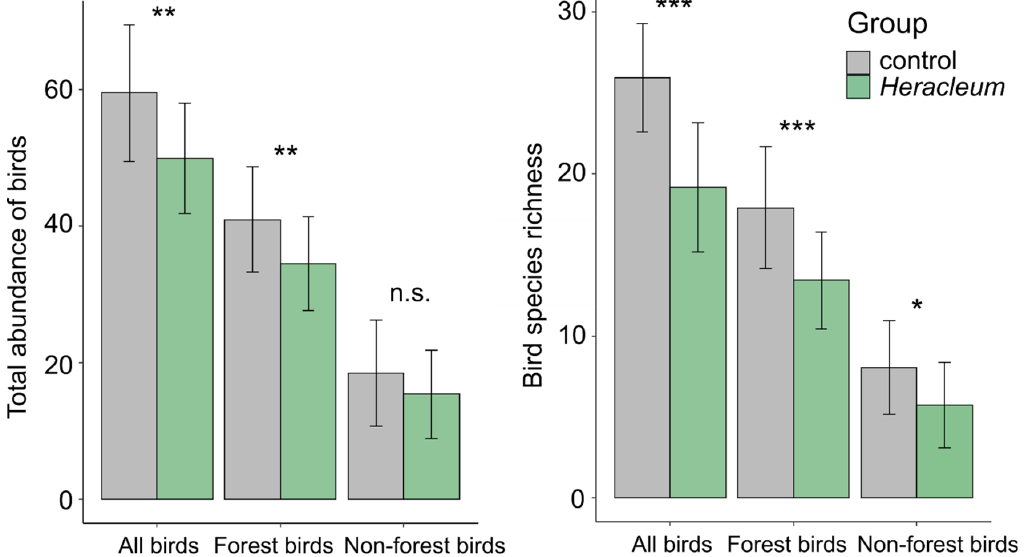
Figure 4. Column graphs showing differences in the bird abundance and number of species of all, forest and non-forest birds between Heracleum and control sites, where “site ID” and “year” were the random effects, while the group (0—control, 1— Heracleum ) was a nominal factor, p values: *** less than 0.001, ** less than 0.01, * less than 0.05, n.s.—non-significant; error bars are standard deviations (number of observation sets during five surveys: N = 190, number of sites: N = 38).